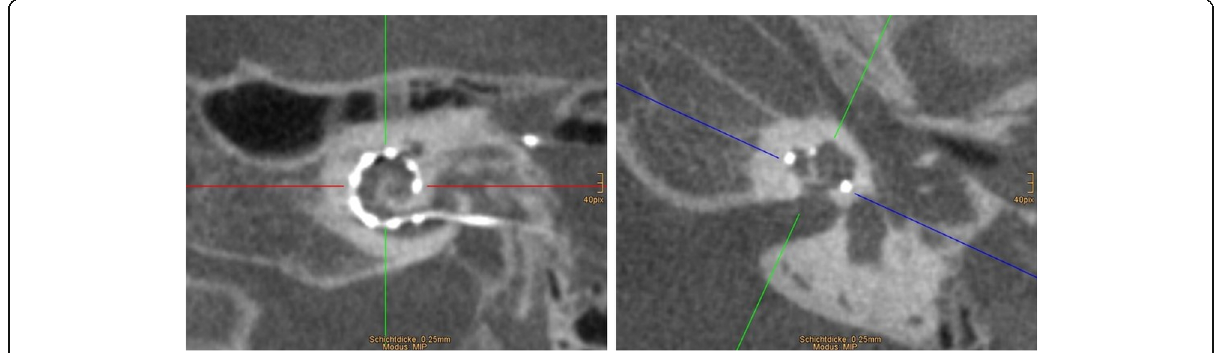
Fig. 19 Postoperative evaluation of cochlear implant location using multiplanar mid-modiolar reconstructions. CBCT paracoronal reconstruction at the basal turn (left image) and paraaxial reconstruction through the modiolus (right image). Maximum intensity projections may be used to visualize the entire electrode